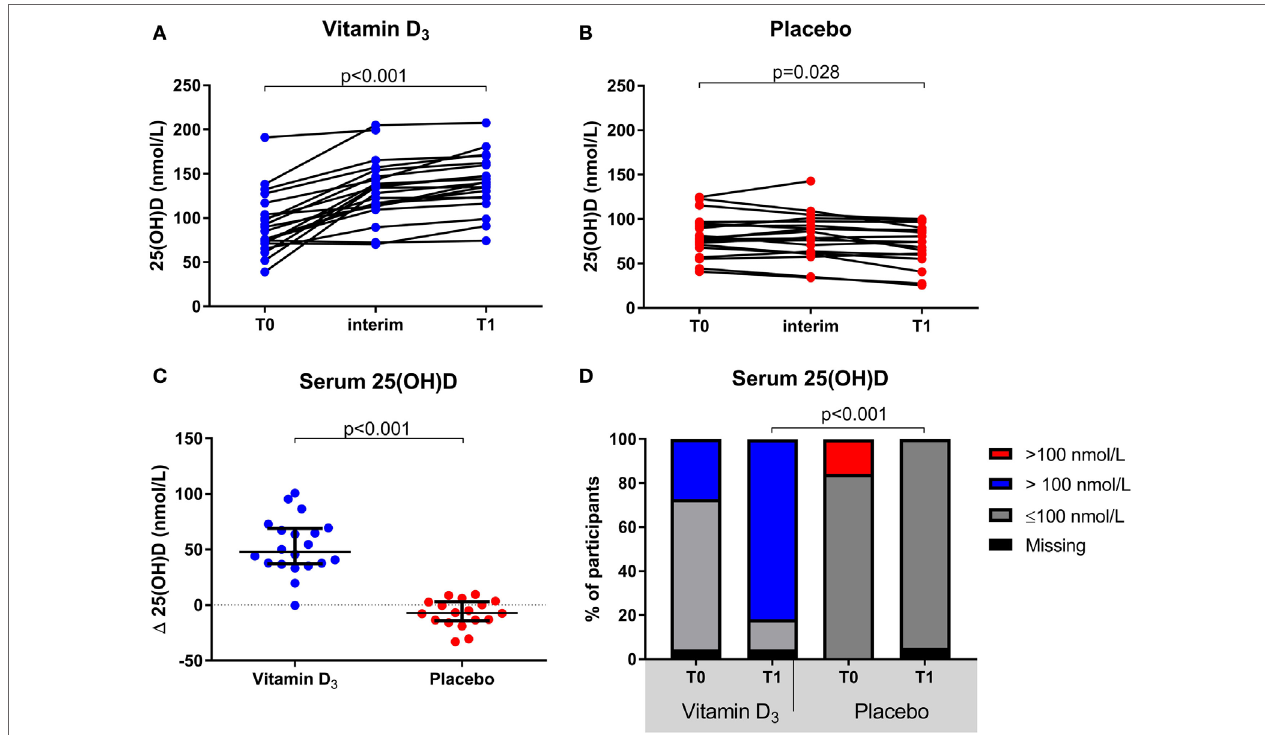
FigUre 2 | Effect of vitamin D 3 supplements on serum 25(OH)D levels. (a) Within group comparisons of serum 25(OH)D levels at T0 (baseline) and T1 (week 16) in the vitamin D 3 supplemented arm ( n = 22), (b) within group comparisons of serum 25(OH)D levels at T0 and T1 in the placebo arm ( n = 19), (c) between group comparisons of the serum 25(OH)D level differences between T1 and T0. (D) group comparisons of serum 25(OH)D levels < and > 100 nmol/L at T0 and T1. p -Values calculated with (a,b) Wilcoxon signed ranks, (c) Mann–Whitney U or (D) χ 2